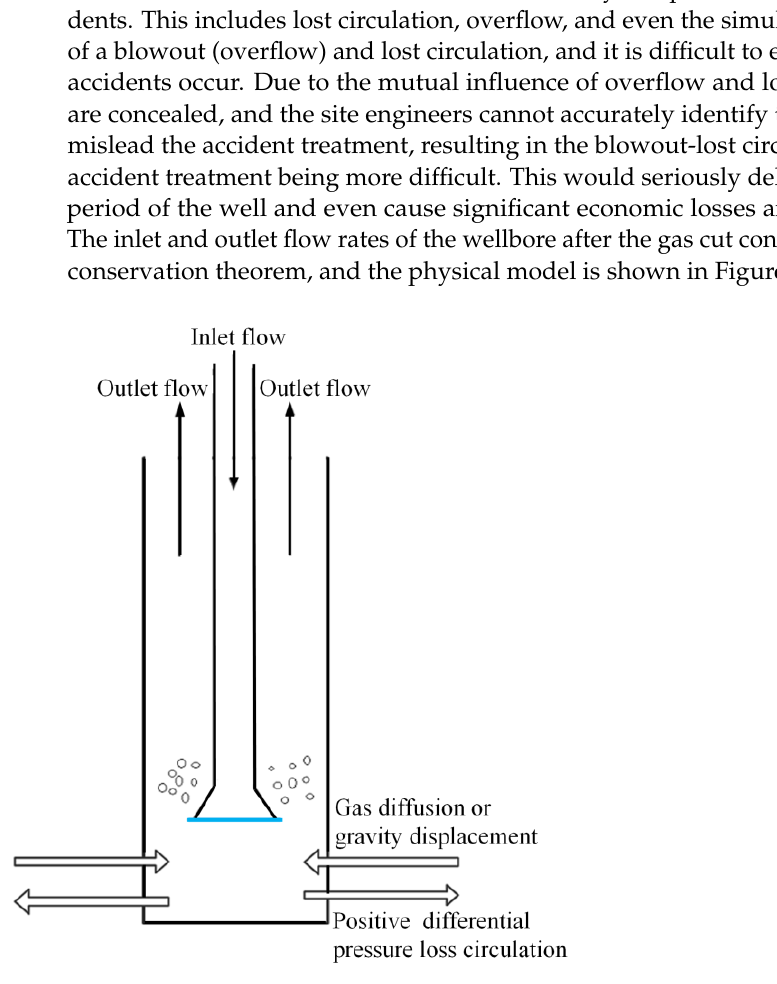
Figure 3. Schematic diagram of wellbore physical model when a gas cut occurs.